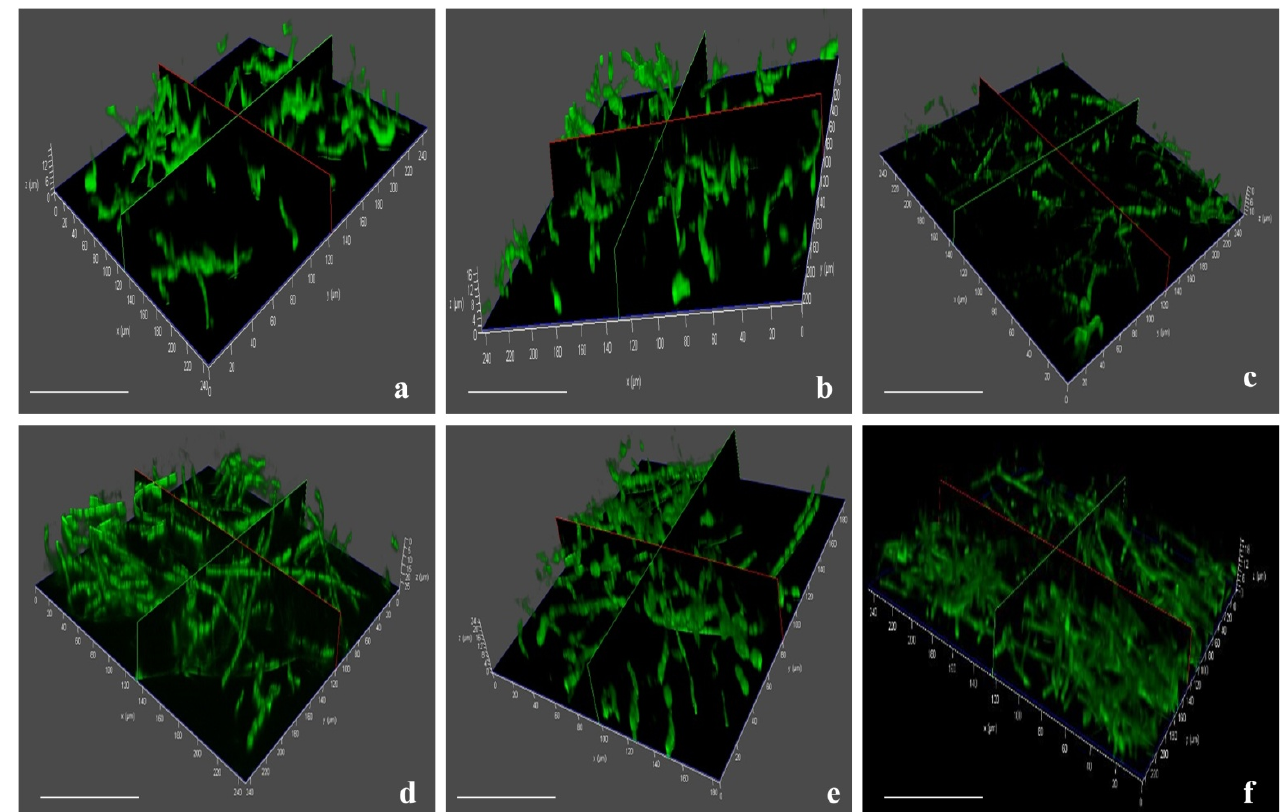
Figure 10. ( a – f ) Represents the three-dimensional (3D) images of corm tissue at 1, 2, 3, 4, 5, and 12 dpi, respectively. Z-axis represents the thickness of the infected tissue. Mycelia were present in all the layers of the tissue (from the base layer to the upper surface). Each bar represents 10 µm.